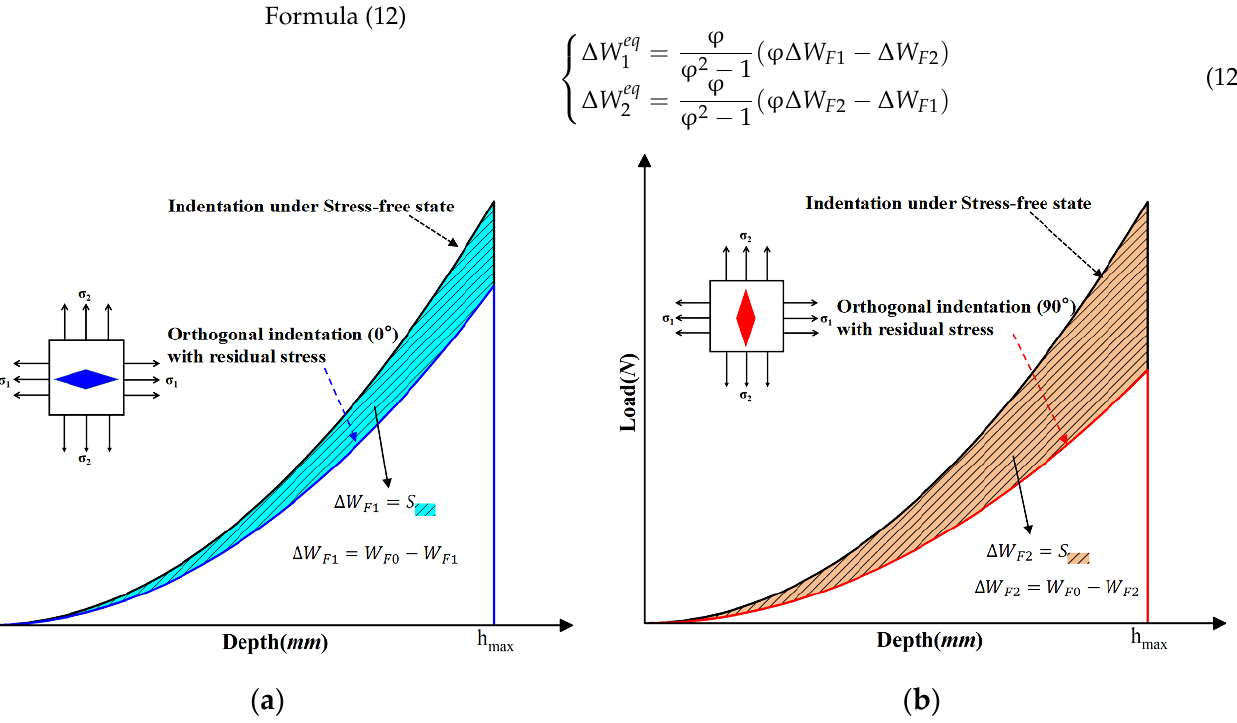
Figure 3. Graphical representation of biaxial indentation energy difference: ( a ) the indentation energy difference when the indenter is pressed crosswise; ( b ) the indentation energy difference when the indenter is pressed longitudinally.